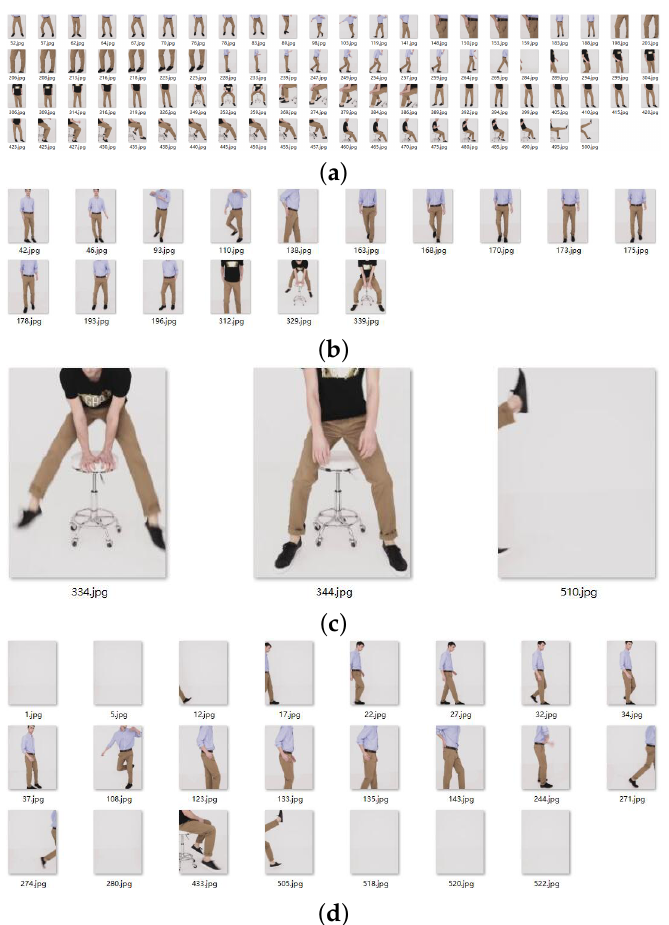
Figure 12. Final result of algorithm. ( a – d ) correspond to the first, second, third, and fourth categories,